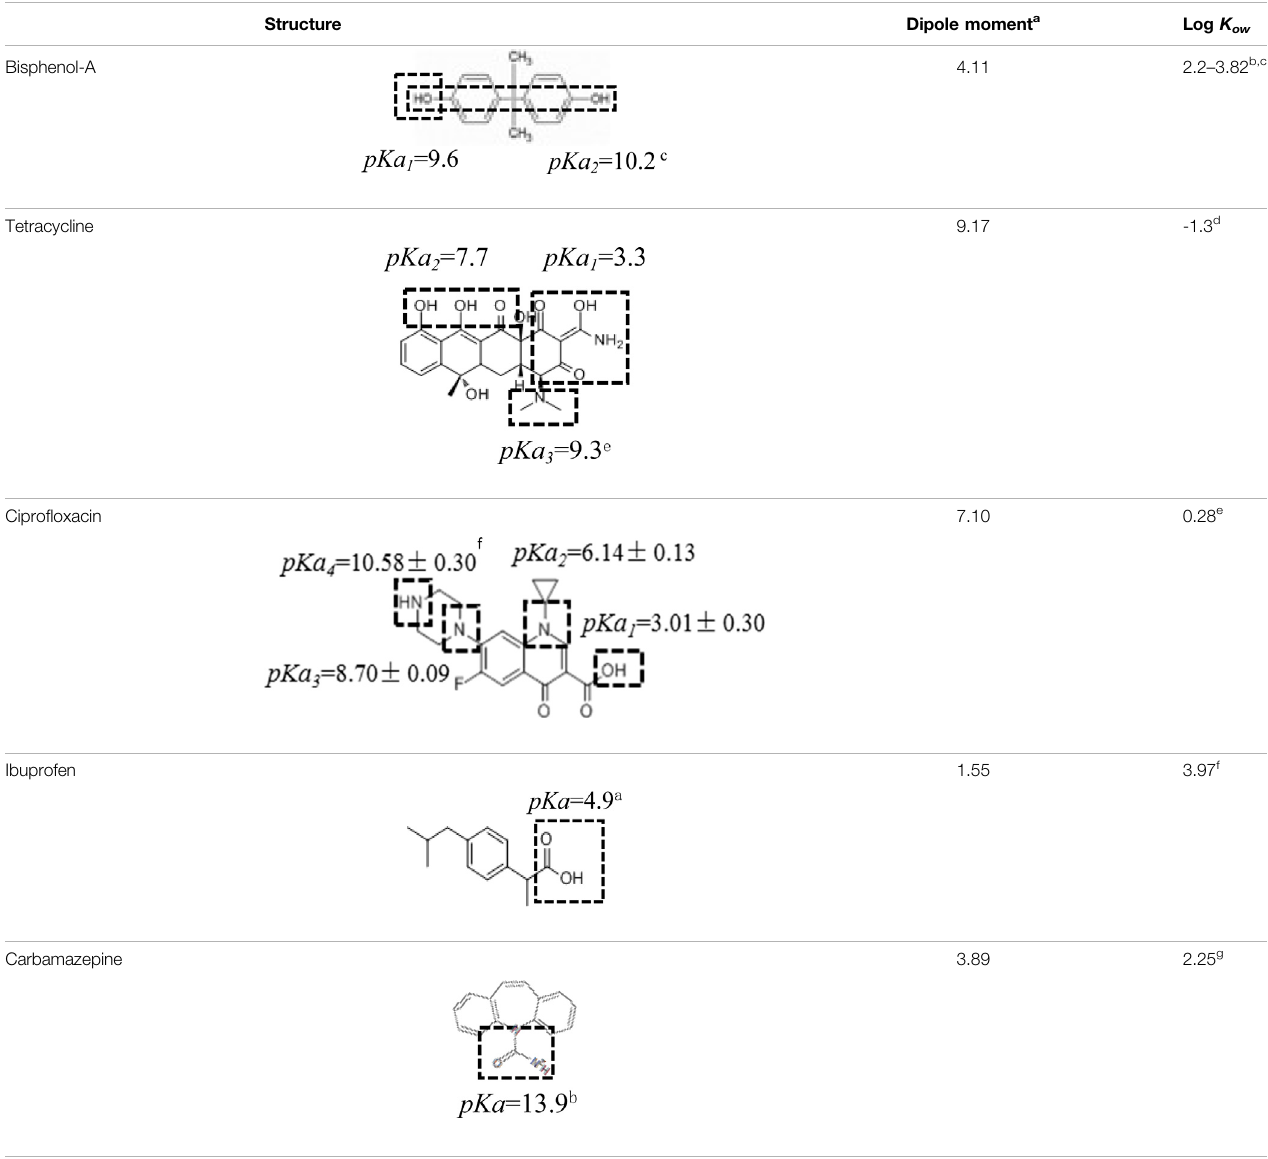
TABLE 1 | Physico-chemical properties of the target PPCPs in this